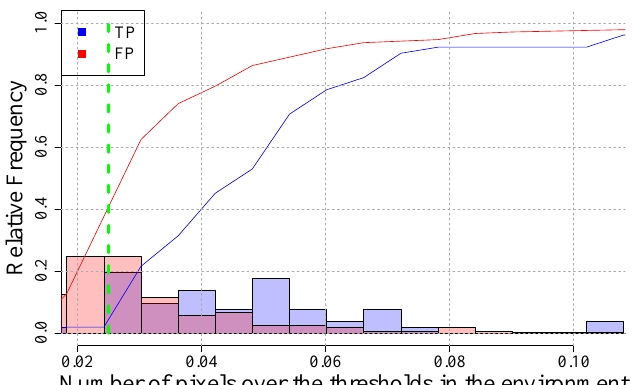
Figure 13. Environment filter distributions. Distribution of the values of the true-positive (TP) in red while distribution of the values of the false-positive (FP) in